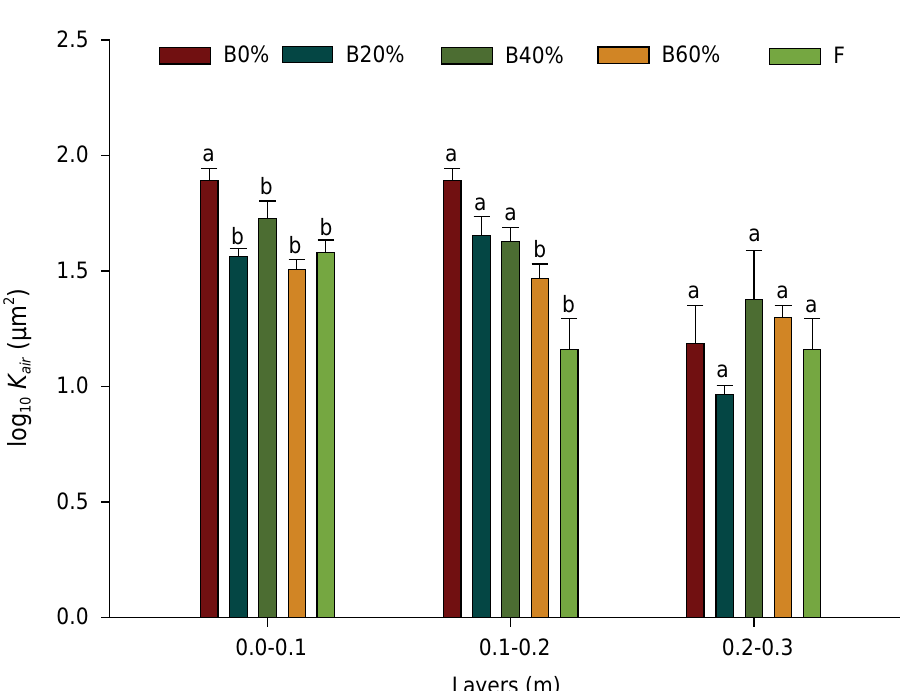
Layers Figure 1. Intrinsic soil air permeability, with the errors of the means, for areas under fig cultivation and secondary native forest (B0% – Control; B20% – 20 % Biofertilizer; B40% – 40 % Biofertilizer; B60% – 60 % Biofertilizer; F – Native forest). Means followed by the same letter in the layer do not differ by Dunnett’s test at 5 % probability.